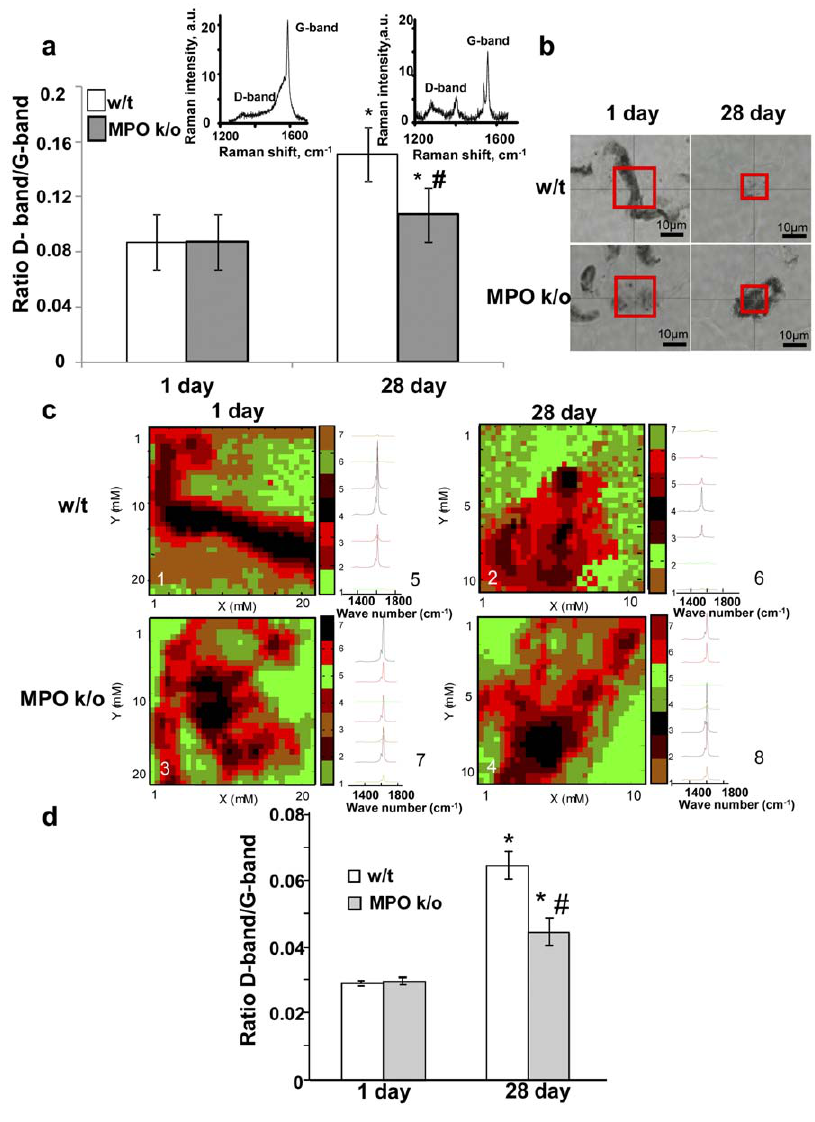
Figure 5. Raman spectroscopic evaluation of ‘‘oxidative’’ defects in SWCNT present in the lungs of w/t and MPO k/o mice at days 1 and 28 post exposure using single point Raman spectroscopy or Raman mapping of different areas within the tissue samples. a. D- band/G- band ratios for single point Raman spectra obtained from samples at days 1 and 28 post exposure. * p , 0.05, vs w/t 1 day post exposure, # p , 0.05, vs w/t 28 days post exposure. Insert – typical Raman spectra (excitation at 633 nm) of solubilized lungs of w/t mice at days 1 and 28 post exposure. b–d. Raman mapping of SWCNT in different areas of the lung sections. b. Examples of bright-field images with a red box indicating the area where 32 6 32 Raman spectra were acquired. Note that the sizes of the acquired areas were different at day 1 and day 28 (20 m m 6 20 m m and 10 m m 6 10 m m respectively), as significantly smaller SWCNT aggregates were detected at day 28 in w/t mice and the scanned areas were adjusted accordingly. c. Raman maps (excitation at 473 nm excitation) with examples of spectra corresponding to each of the clusters. d. D-band/G-band ratios for Raman spectral maps obtained from the lung of w/t and MPO k/o mice at days 1 and 28 post exposure.